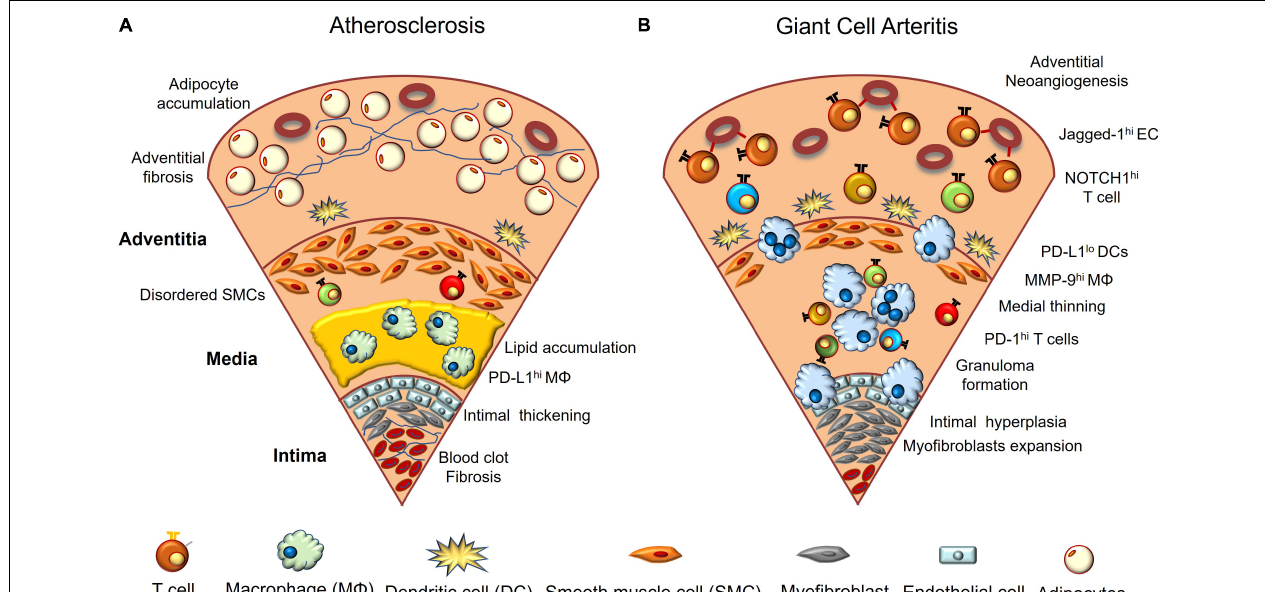
FIGURE 1 | Vascular aging and giant cell arteritis. (A) In aged vasculature, lipids accumulate between the intima and media, and macrophages and foam cells phagocytose them. Vascular endothelial cells are multilayered, and blood clots composed of red blood cells and platelets adhere to the luminal surface of the intima. Fibrosis and calcification are often observed. The arrangement of vascular smooth muscle cells becomes irregular and adipocytes accumulate in the adventitial layer. (B) GCA-affected arteries are characterized by infiltration of macrophages and activated CD4 + T cells. NOTCH1 ligand (Jagged-1)-expressing endothelial cells interact with NOTCH1 expressed on CD4 + T cells in the adventitia and polarize T cell differentiation toward Th1 and TH17. Macrophages and multinucleated giant cells release excess proteolytic enzymes such as matrix metalloprotease-9 (MMP-9), disrupting the external elastic membrane, and infiltrated T cells also release various cytokines. As a result, the media becomes thin and the inner elastic membrane collapses. In the intima, myofibroblasts overgrow and block the lumen of blood vessels. Angiogenesis is prominent in the adventitia. Dendritic cells present at the border of the adventitia and media have decreased PD-L1 expression; however, activated T cells highly express